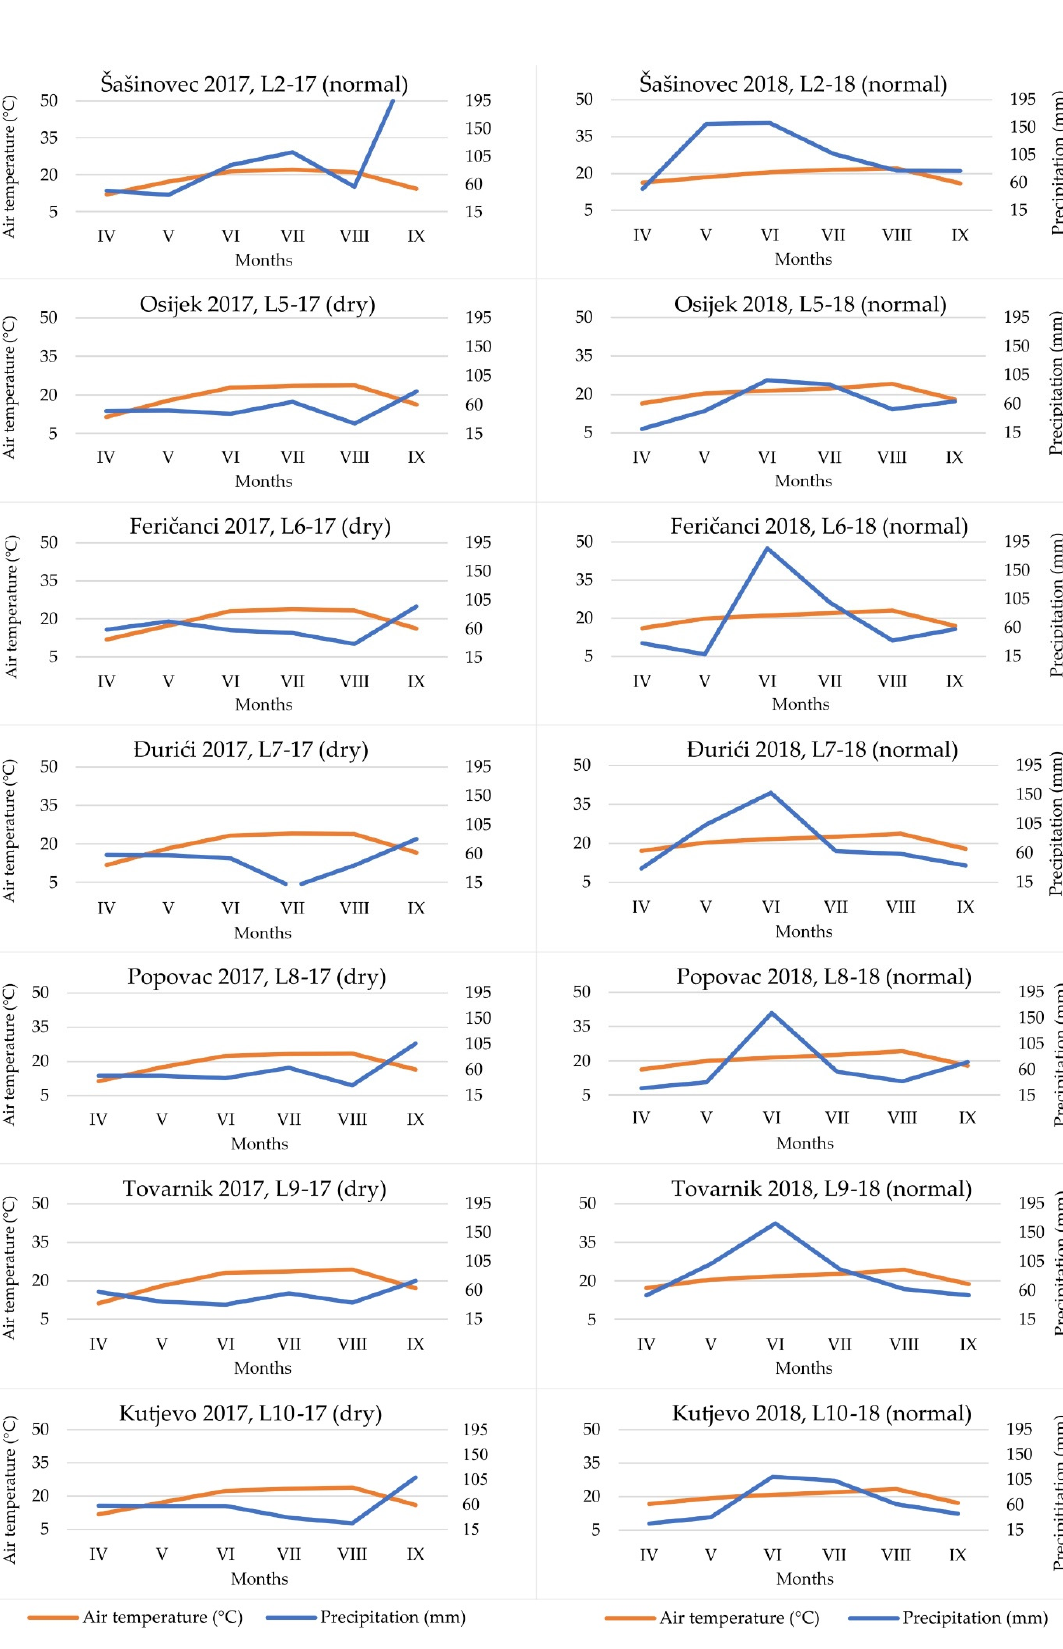
Figure 1. Heinrich Walter climate diagram for monthly precipitation and mean air temperature across environments during the vegetation period (April–September).